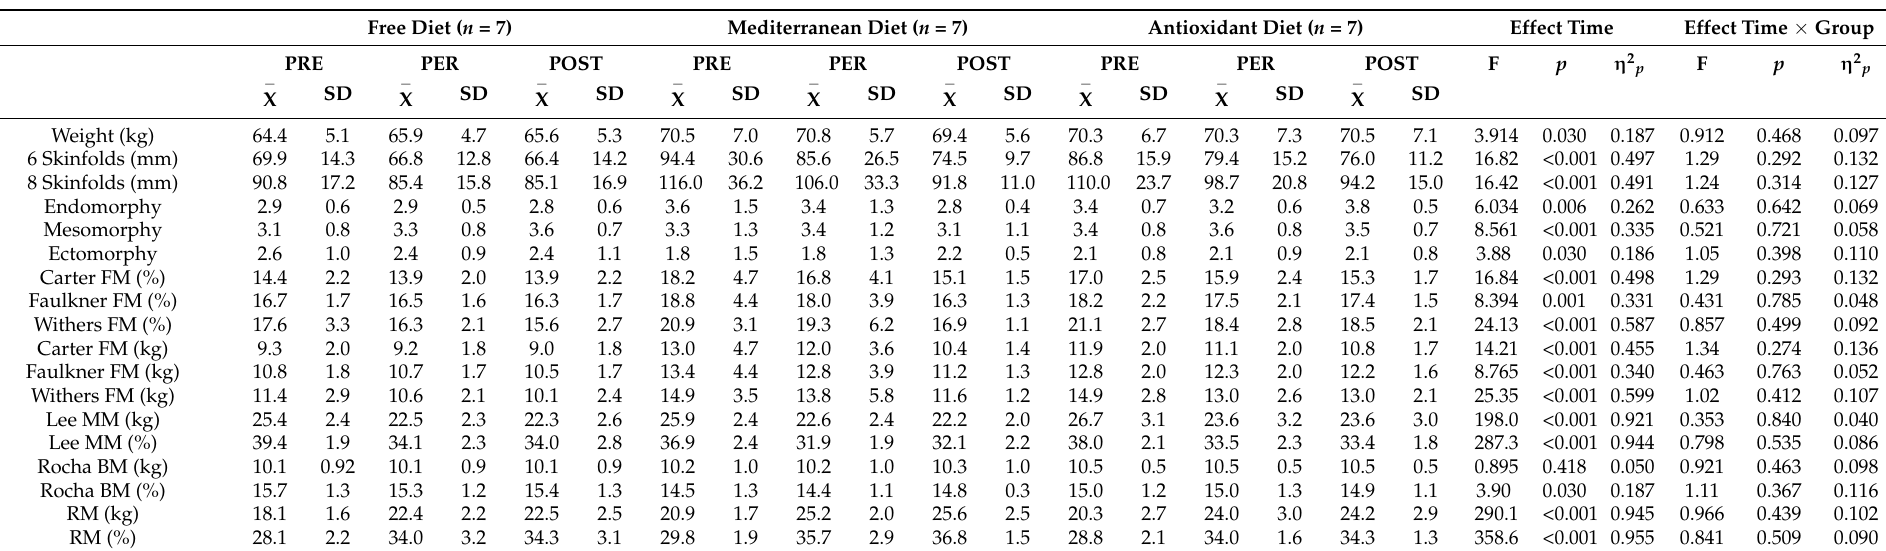
Table 5. Body composition variables measured by anthropometry at pre-, during and post-intervention times in the free diet, Mediterranean diet, and antioxidant-rich diet